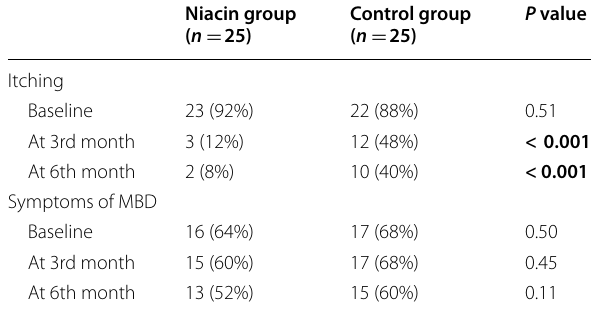
Table 3 Clinical findings among studied